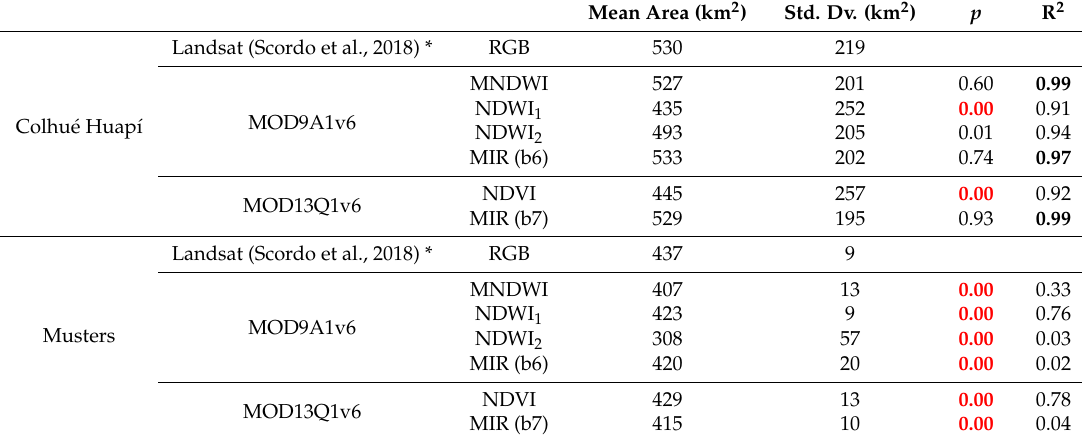
Table 4. Mean and standard deviation of the time series of the musters (MU) and CH areas calculated with Landsat (reference sample) and the indexes and bands calculated and/or obtained from MODIS